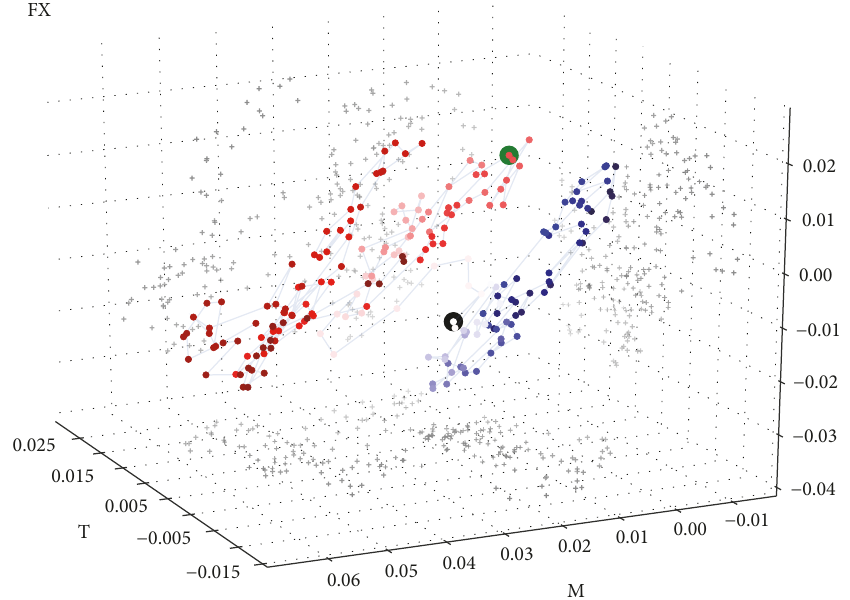
Figure 4: 200 time points showing the progression of the three information features memory (M), transfer (T), and integration (S) computed with a time delay of 1 day (similar to 𝑡 = 1 for ECA). The color indicates the time difference with September 15, 2008 (big black dot), which we consider the starting point of the 2008 crisis, from dark blue (long before) to dark red (long after) and white at the crisis date. The data spans from January 1, 1999, to April 21, 2017; the large green dot is the last time point also present in the IRS data in 2011. In this information space we clearly observe signs of a two attractor regimes separated by a sudden regime shift. Mutual information is calculated using a sliding window of 𝑤 = 1400 days; the 200 windows partially overlap and are placed uniformly over the dataset, where the first and last window include the first and last day of the dataset, respectively. The gray plus signs are the projections of the 3D points on the visible side faces for better visibility of the positions of the